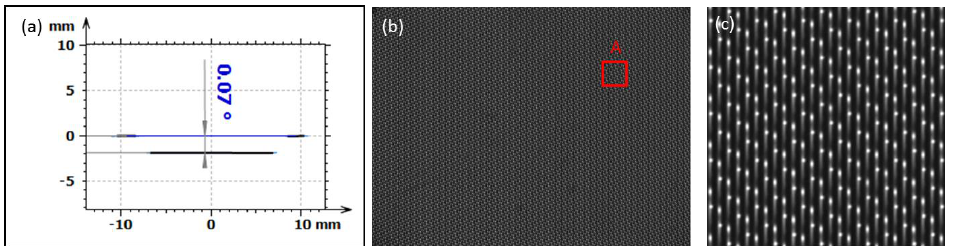
Figure 11. ( a ) Angle of 0.07 ◦ between the mounting features and the microstructured area measured with laser autofocus probe system; ( b ) Image of the resulting light spectra on the camera system using the molded MLA; ( c ) Close view of the light spectra at position